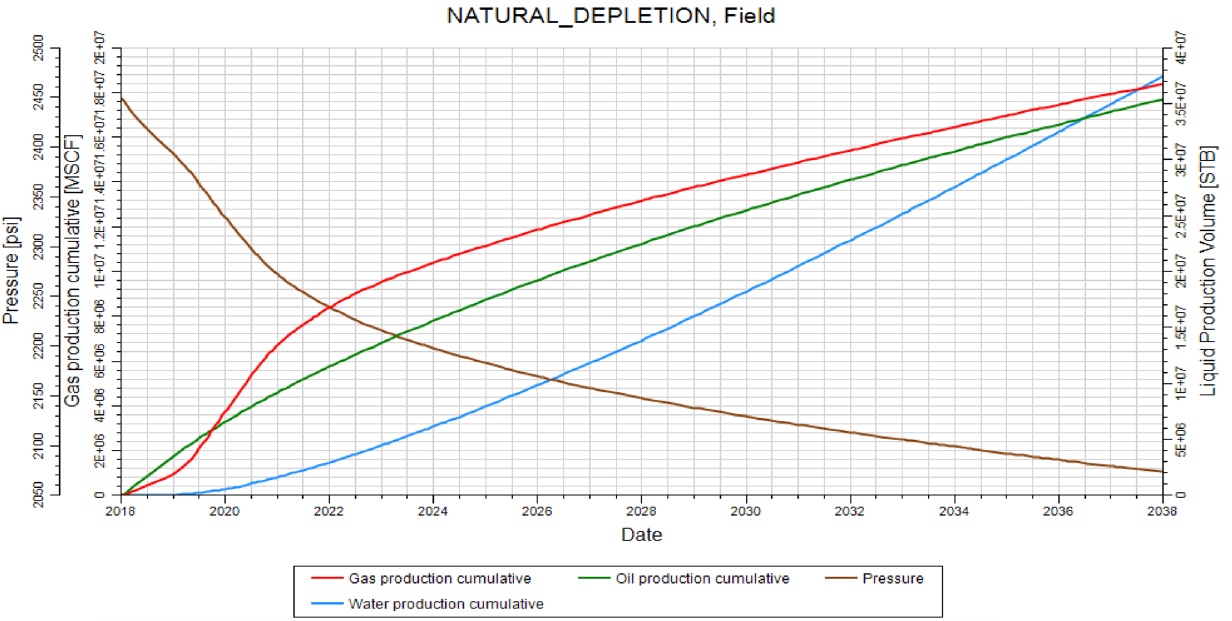
Fig. 8 Reservoir production performance plot at natural